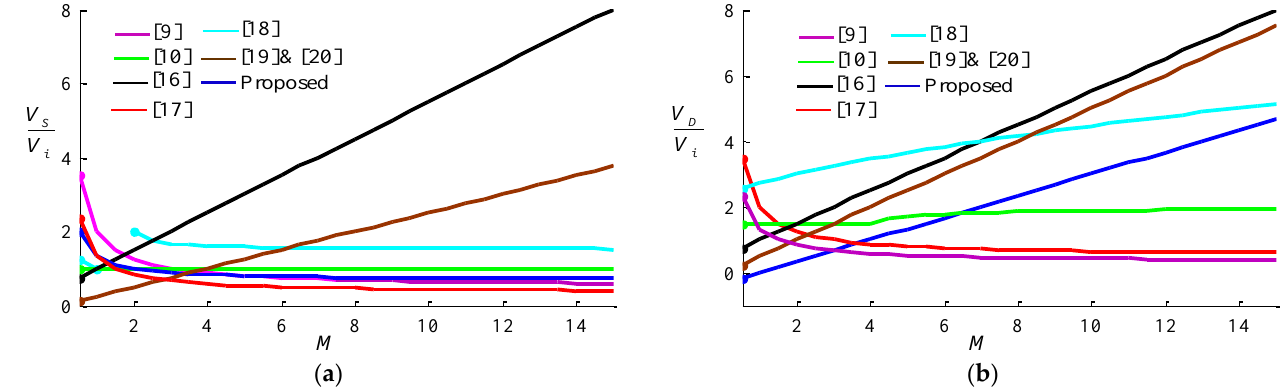
Figure 6. The maximum normalized voltage stress for ( a ) switch and ( b ) diode. Table 2. Comparison between proposed converter and the existing topologies. Elements/Ref.